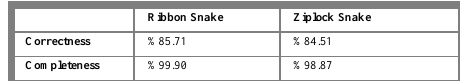
Table 8: The results of extraction of salient roads According to the table 8 Ribbon snake and Ziplock snake gives